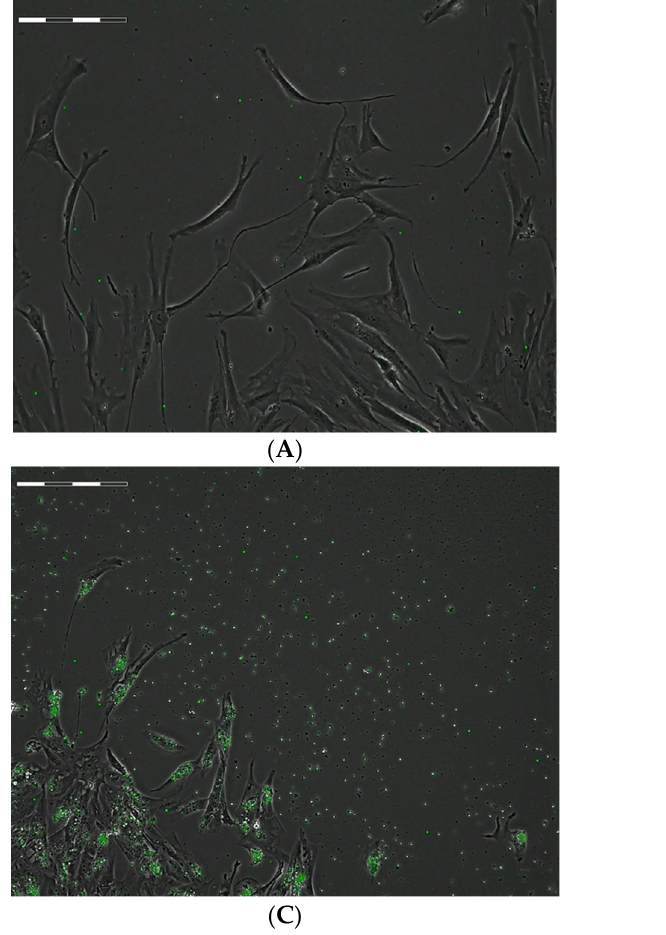
Figure 1. Examples of Cell-IQ phase contrast images of FITC-labelled microcapsules internalization by hAMSCs within 24 h phagocytosis in dependence to the calculated number of vehicles in the intercellular medium. ( A )—Control cells without capsules; ratio of cells to capsules: ( B )—1:10; ( C )—1:20; ( D )—1:45. Scale bar is 200 µm.